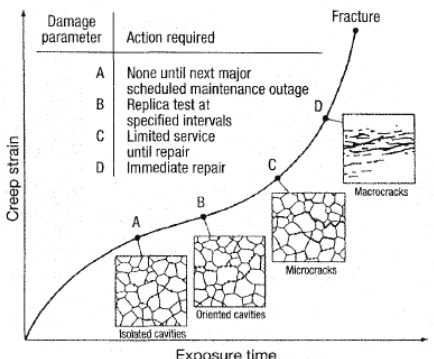
Figure 4: Overview of possible damage to the established method of replica